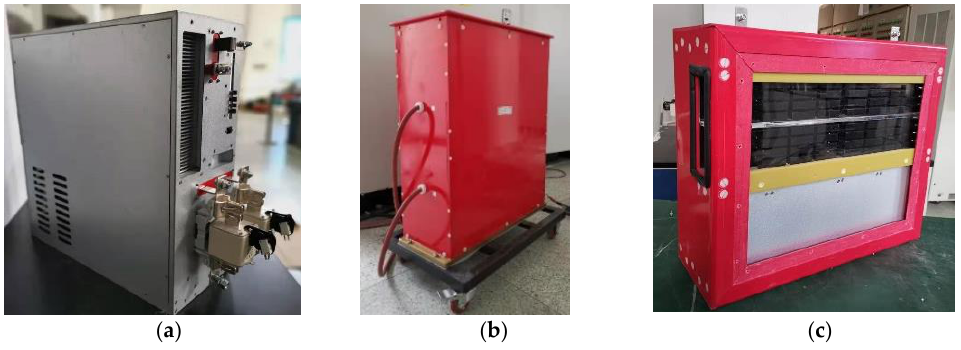
Figure 11. 5 kV/80 kW standard power module: ( a ) Low voltage module; ( b ) High frequency transformer; ( c ) High voltage rectification module.